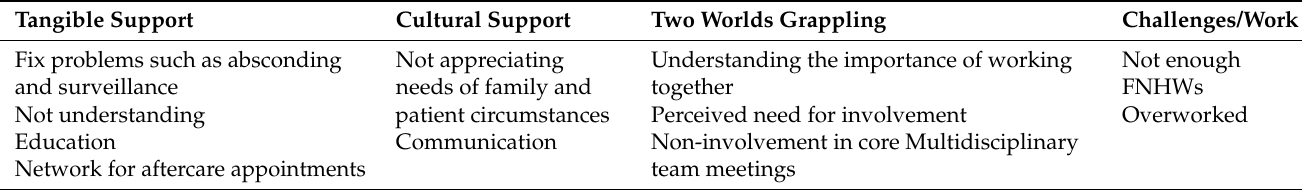
Table 3. Multidisciplinary burn team member’s perspectives and